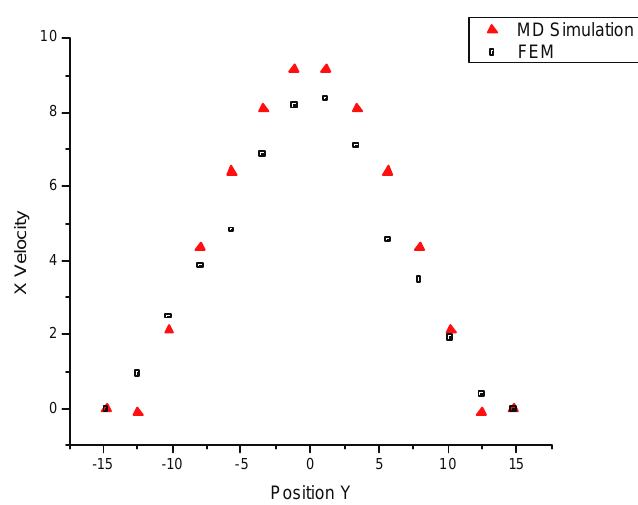
Figure 11. X velocity profile at position x=105 in Case 5